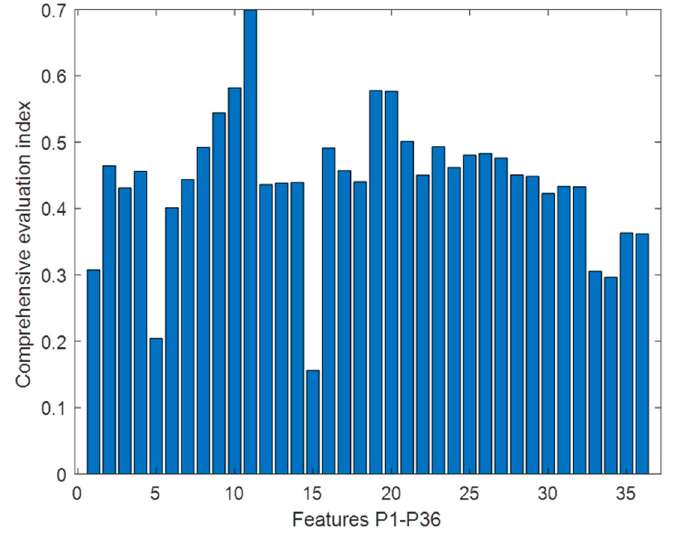
Figure 6. Comprehensive evaluation index of degradation features.